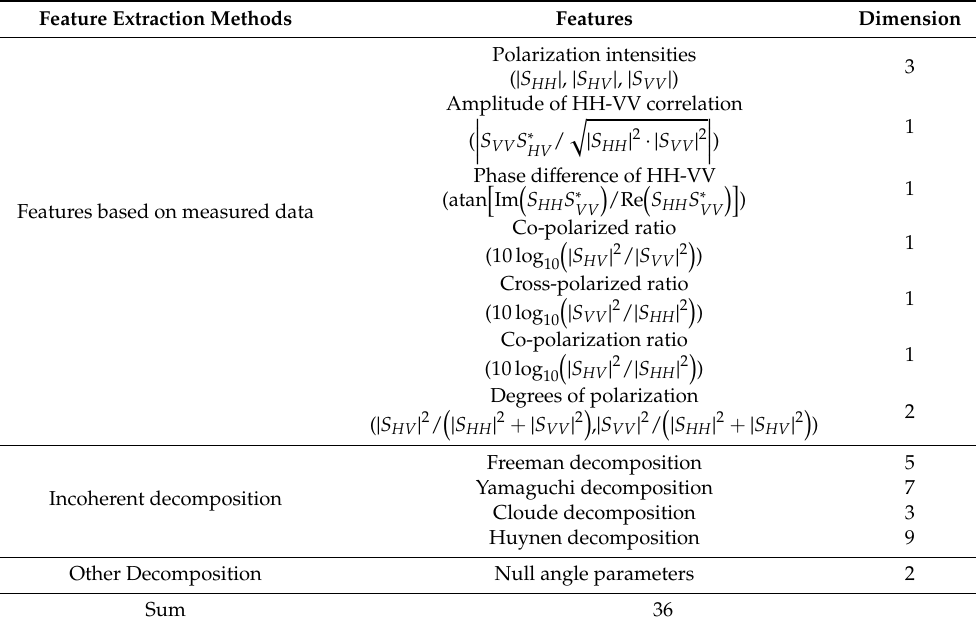
Table 2. The 36 dimensional features from a single temporal PolSAR image.